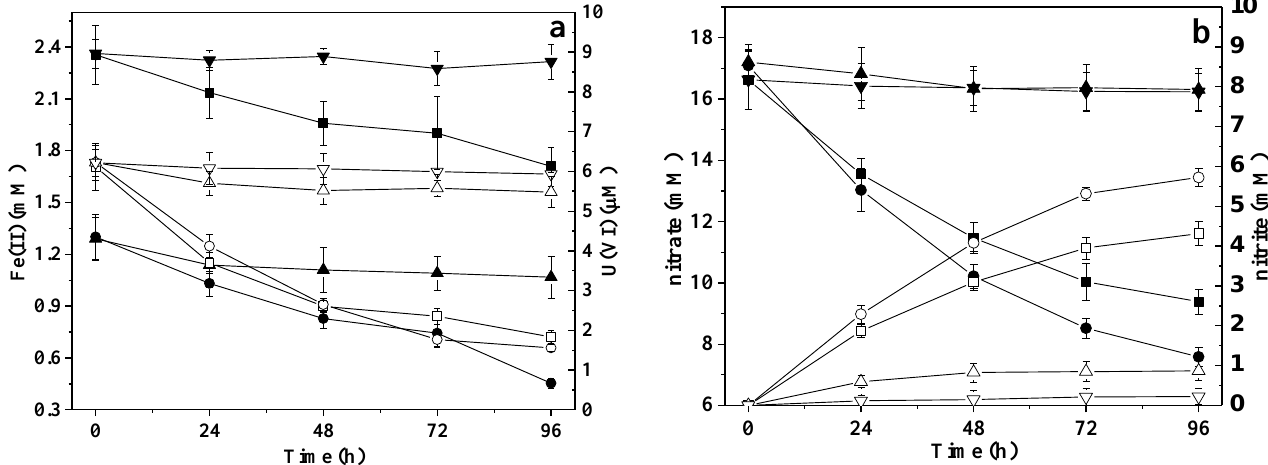
Figure 2. The effects of pH on changes in Fe(II), U(VI), nitrate, and nitrite concentrations during the growth of Clostridium sp. PXL2. ■ and □ , pH 5.5; ▼ and ▽ , pH 5.5 (non-inoculated control ① ); ● and ○ , pH 7.0; ▲ and △ , pH 7.0 (uninoculated control ② ). Filled symbols, Fe(II) and nitrate; open symbols, U(VI) and nitrite. ( a ), Fe(II) and U(VI); ( b ), nitrate and nitrite. Data shown are means ± SD ( n = 3).